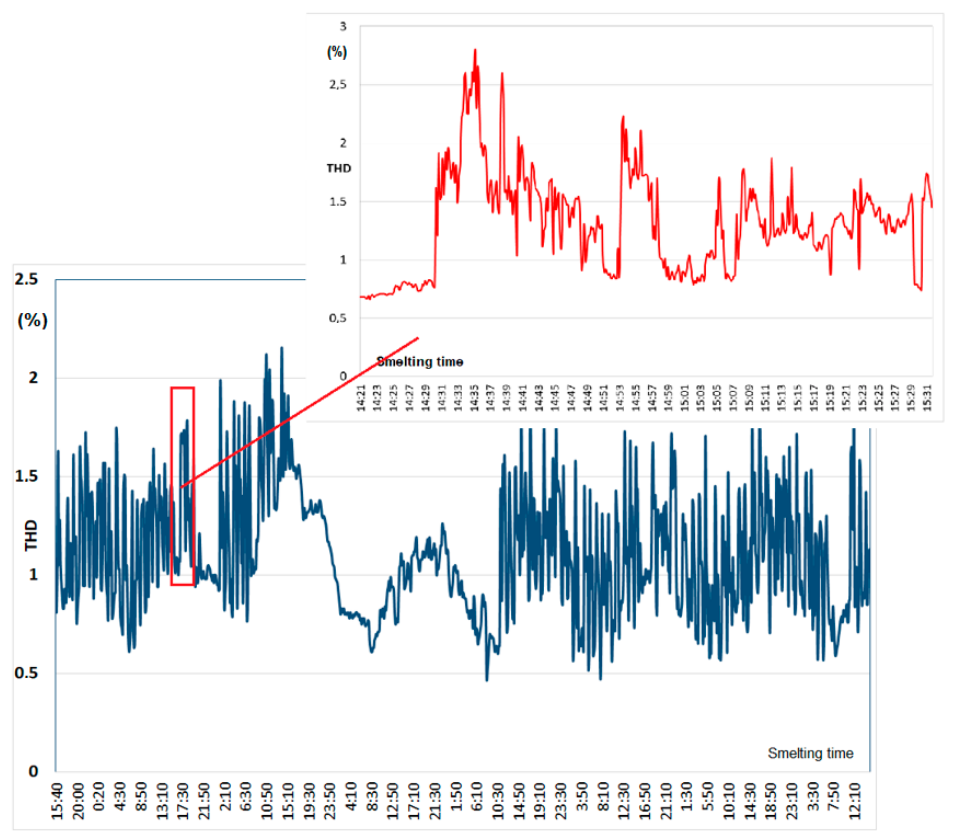
Figure 18. Changes in the total harmonic distortion (THD) coefficient measured during the week and during one melt.